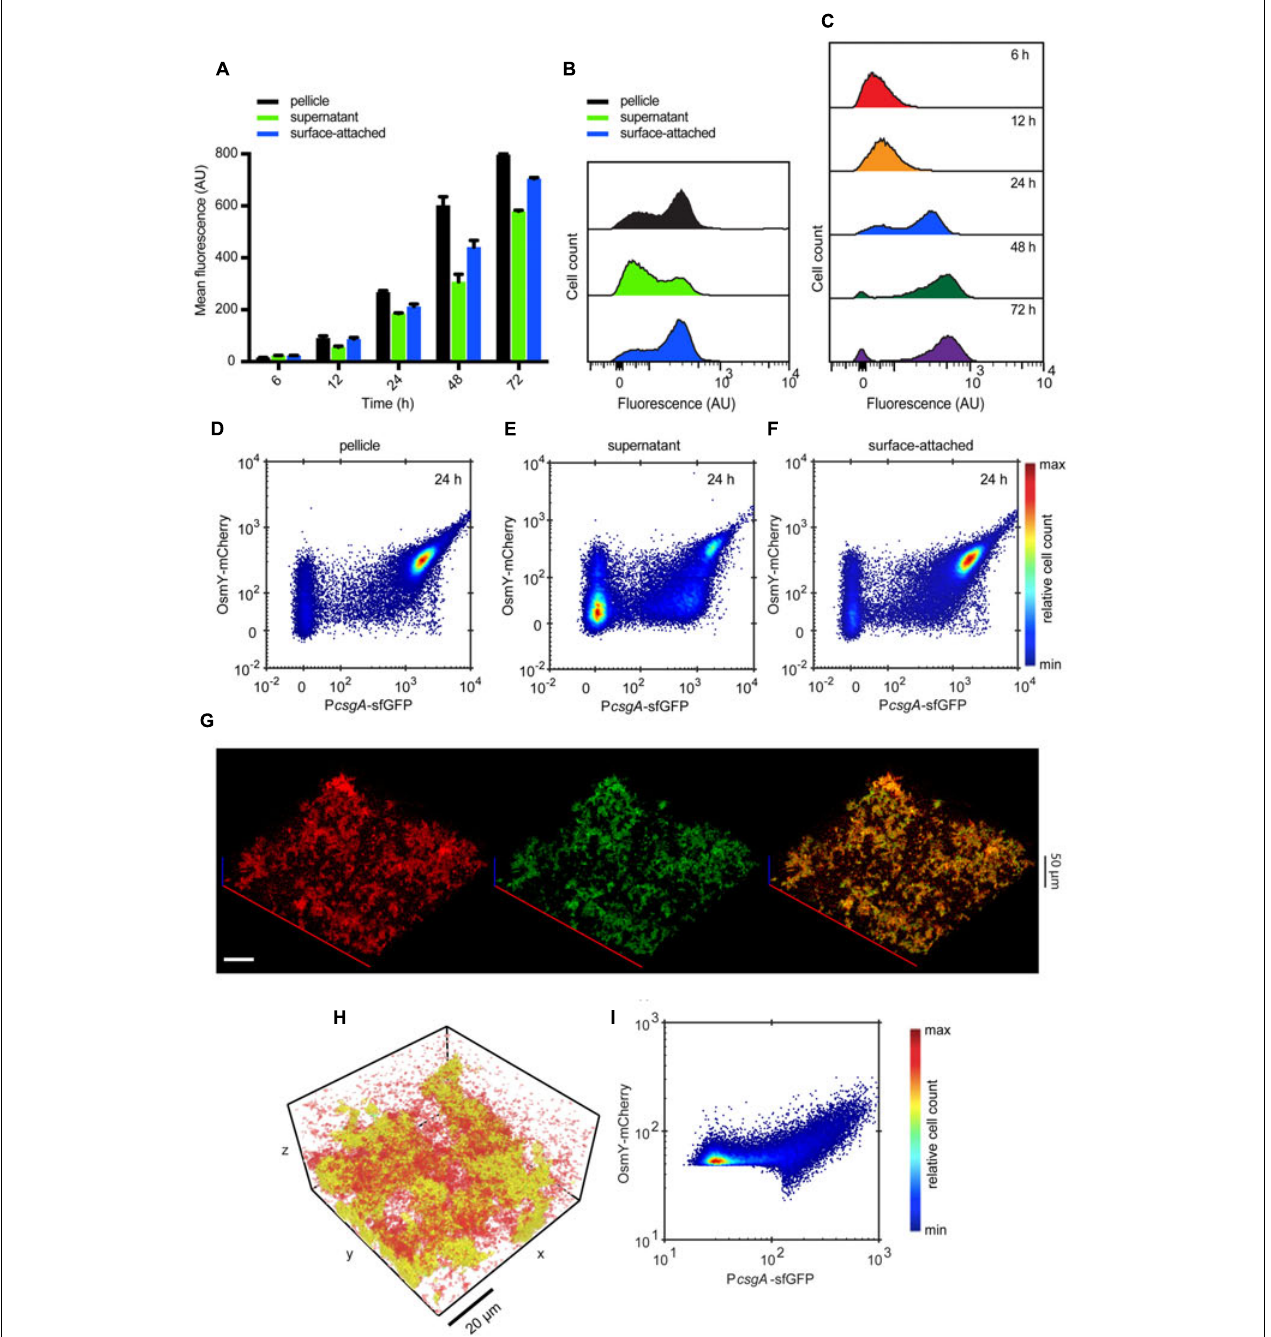
FIGURE 5 | Expression of curli fibers partly correlates with σ S activity. (A) Mean of OsmY-mCherry fluorescence intensity measured in the indicated culture fractions by flow cytometry. Shown are mean values calculated from three independent experiments and standard errors. (B) Flow cytometry analysis of OsmY-mCherry fluorescence detected in individual culture fractions at 24 h. (C) Changes in the single-cell expression of σ S reporter measured over time in surface-attached cells. (D − F) Scatter plots showing expression of P csgA -sfGFP and OsmY-mCherry in (D) pellicle, (E) supernatant and (F) surface-attached cells at 24 h. The color scale shows relative cell count from lowest (blue) to highest (red). (G) Confocal fluorescence microscopy images (maximum projection) showing the expression of P csgA -sfGFP (green) and OsmY-mCherry (red) in biofilms at 24 h. Scale bar, 40 µ m. (H,I) Quantification of relative expression of P csgA -sfGFP and OsmY-mCherry in a region of the submerged biofilm shown in (G) , with a visual representation of the segmentation analysis (H) and relative expression in individual segments shown as a scatter plot (I) . In (H) green regions are P csgA -sfGFP-positive, red regions are OsmY-mCherry-positive and cells in yellow volumes express both fluorescence markers. Note that sharp cutoffs in (I) correspond to the segmentation thresholds applied in image analysis (see Materials and Methods). The color scale shows relative cell count from lowest (blue) to highest (red).